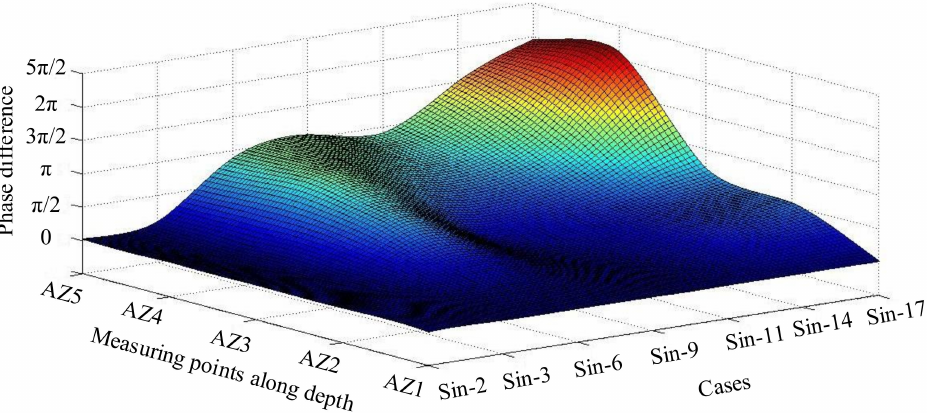
Figure 13. Phase difference in FF model.